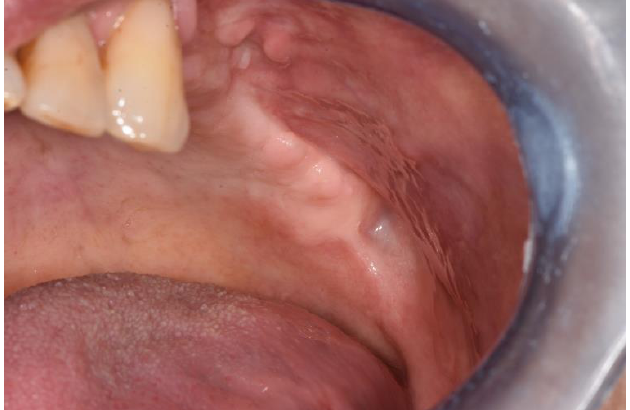
Figure 11. Clinical view at one year follow up.